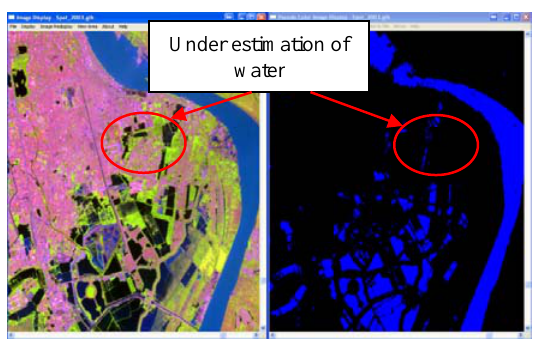
Figure 6. Spot 5 colour composite image (left) and water extraction by level slicing of SWIR band